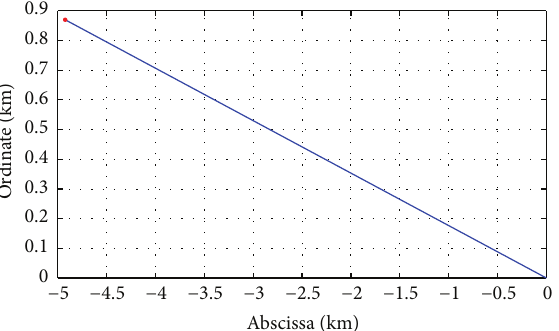
Figure 15: Vehicle A—target engagement scenario.